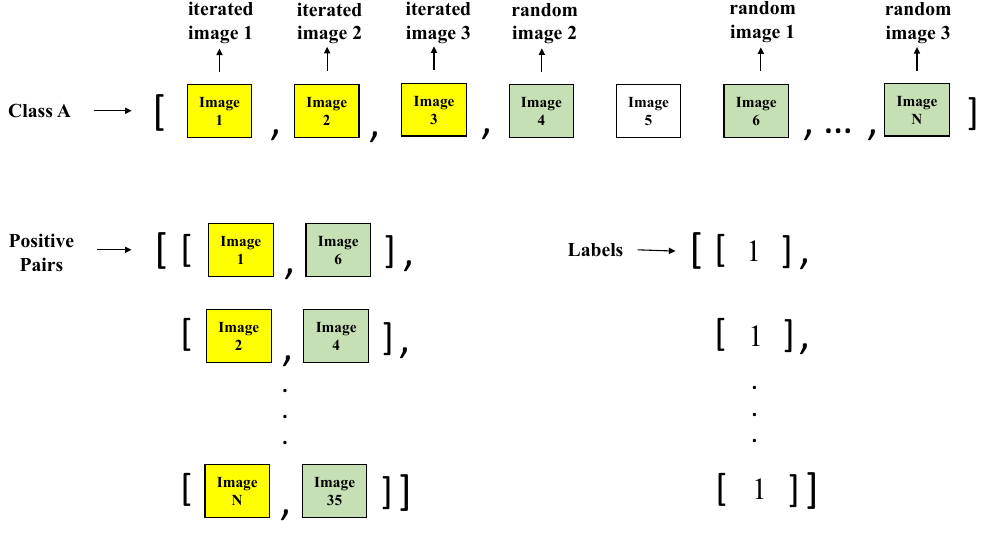
Figure 10. Positive pairs’ creation process. For the creation of negative pairs, a similar process is carried out, but the random image is chosen from class B. Then, a label with the value of 0 is added to the labels array previously created in order to maintain the index relation between the pair and the label. This iterative process is carried out also for class B (the negative image comes from class A and positive image comes from class B), so it can be ensured that all the images are used. This process can be observed in Figure 11.